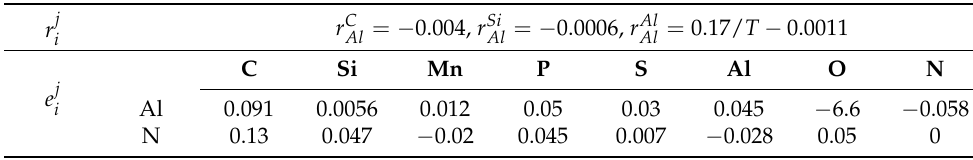
Table 2. Primary and secondary interaction coefficients e j ous literature [25].